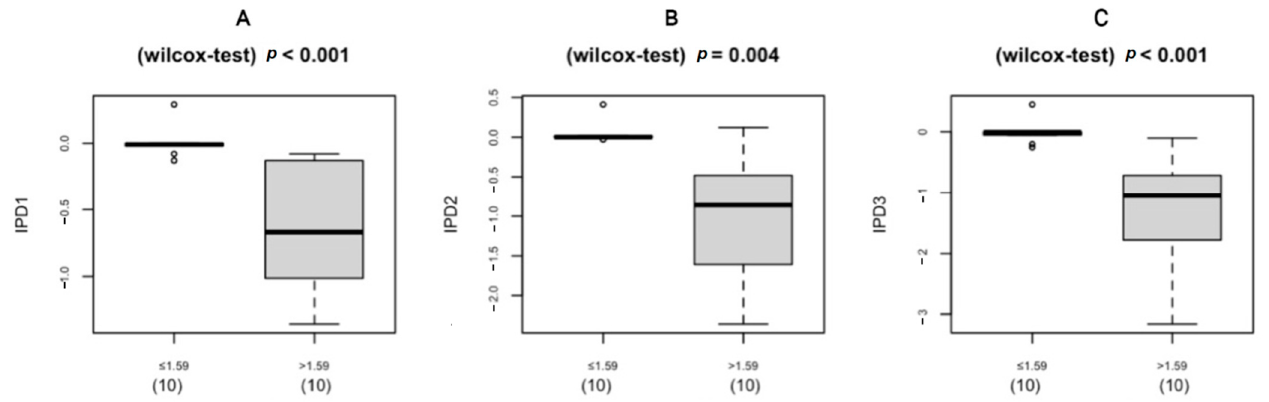
Figure 4. Boxplot of the IPD distribution for eyes below (left) and above (right) the cutoff of 1.59% at baseline (V1): ( A ) IPD1 (V1 vs. V7); ( B ) IPD2 (V1 vs. V8); ( C ) IPD3 (V1 vs. V9); IPD, ischemic percent difference; V, visit.